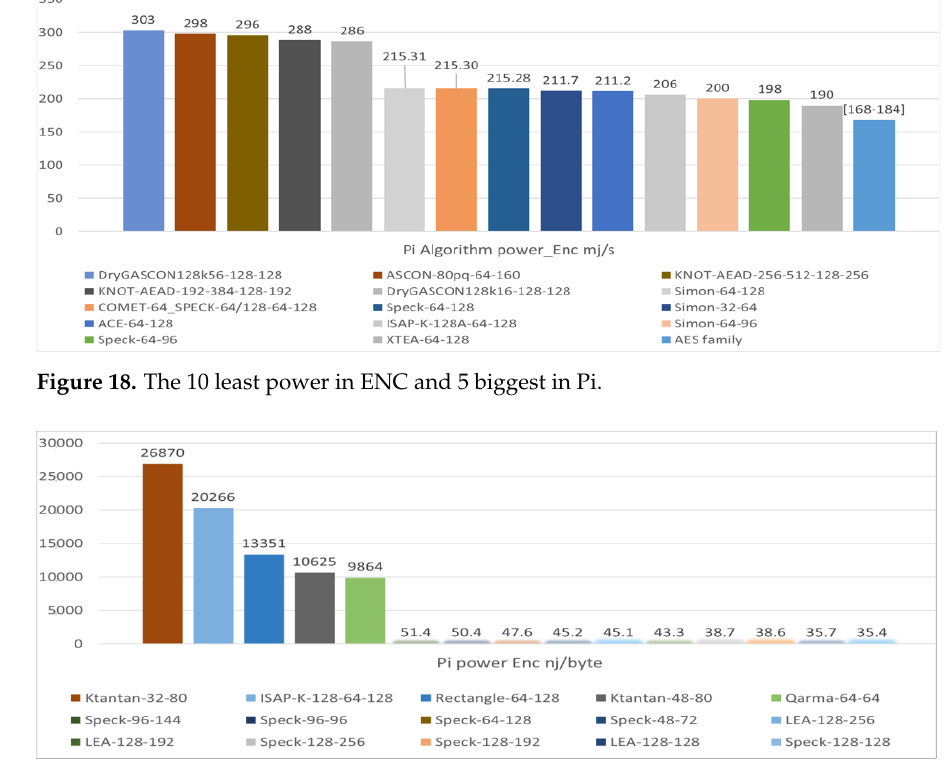
Figure 19. The 10 least energy in ENC and 5 biggest in